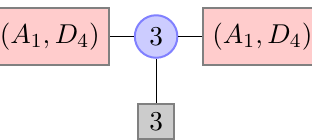
Figure 1 . The quiver diagram describing the simplest (i.e., lowest rank) AD generalization of Argyres-Seiberg duality in the SU(3) duality frame. The total flavor symmetry is U(3). In [11], this theory was called the “